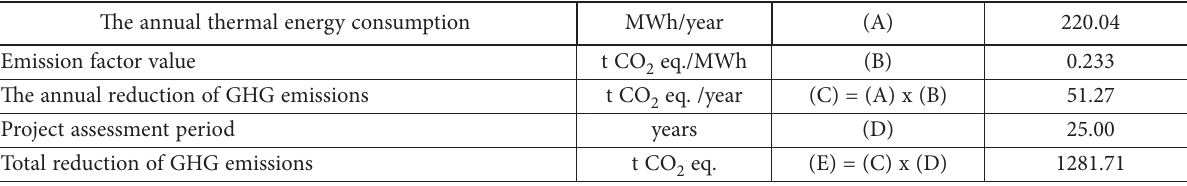
Table 9. Reduction of greenhouse gas (GHG) emissions (CO 2 eq.) for Alternative 5*